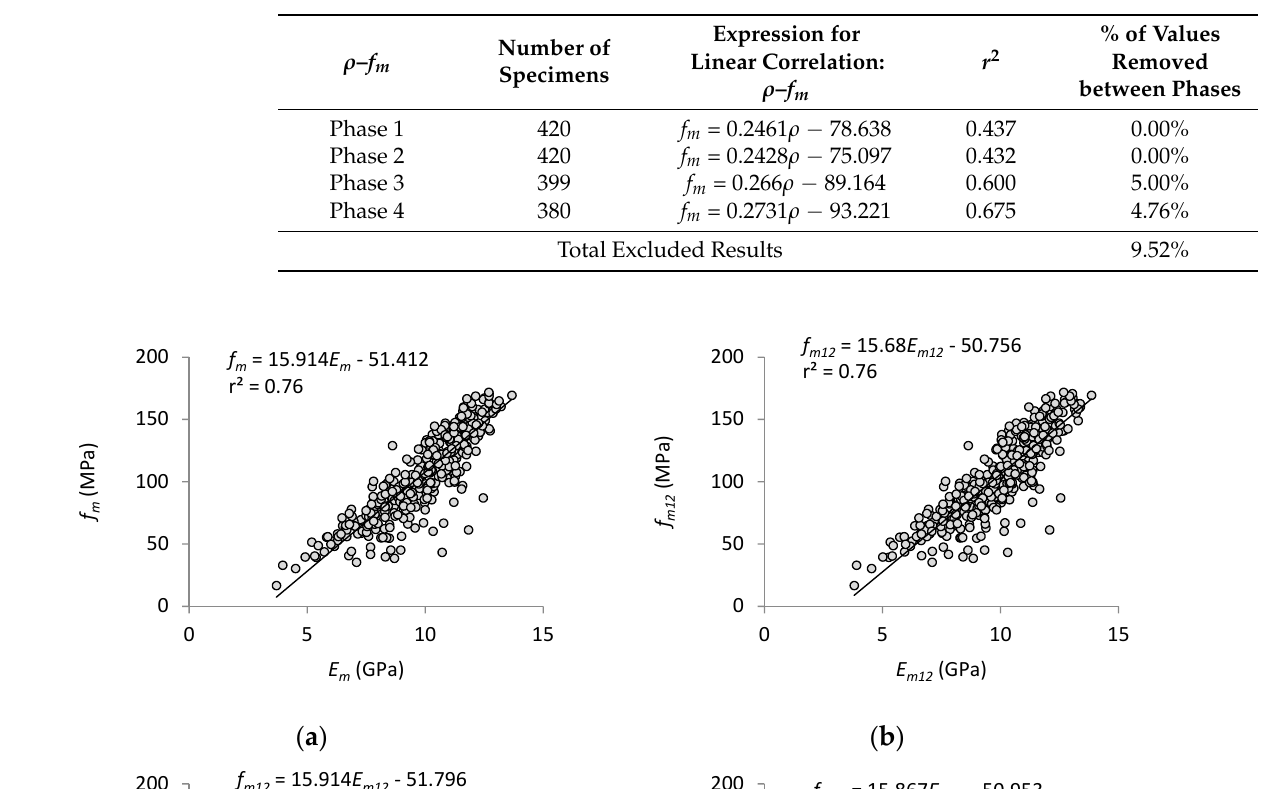
Table 5. Correlation between density ( ρ ) and bending strength ( f m ).